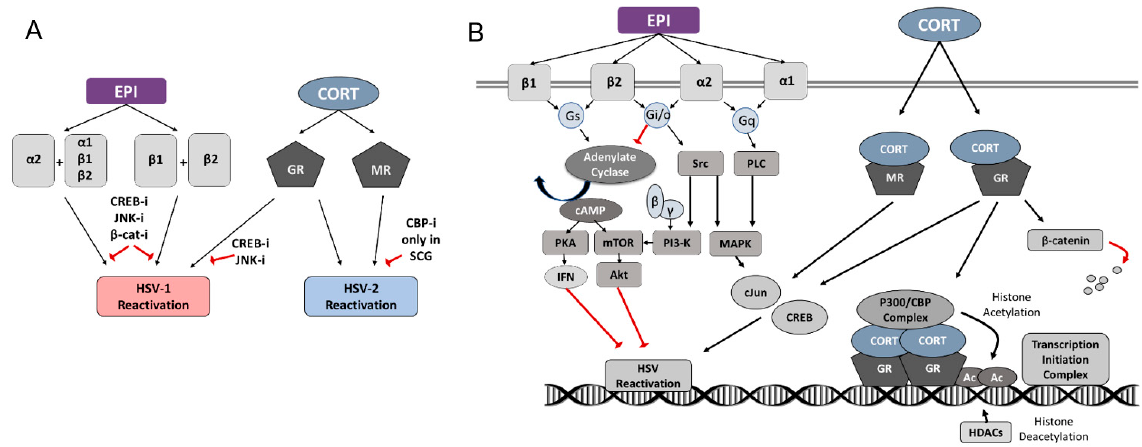
Figure 7. Adrenergic and glucocorticoid signaling pathways and HSV reactivation pathways. ( A ) Epinephrine (EPI) induces HSV-1 reactivation through the activation of α 2 and any other AR, or through the activation of β 1 and β 2, which can be blocked by the inhibitors of CREB, JNK, or β -catenin. Corticosterone (CORT) induces HSV-1 reactivation through the glucocorticoid receptor (GR), which can be blocked by the inhibitors of CREB or JNK. CORT induces HSV-2 reactivation through either glucocorticoid (GR) or mineralocorticoid (MR) receptors; the only factor we identified able to block HSV-2 reactivation was a CBP inhibitor, and only in SCG neurons. ( B ) Epinephrine (EPI) activates multiple adrenergic receptors on peripheral neurons ( α 1, α 2, β 1, β 2), which couple with different G-protein α subunits (Gq, Gi/o, Gs), which can activate different signaling cascades. Corticosterone (CORT) activates signaling cascades through cytosolic glucocorticoid (GR) and mineralocorticoid (MR) receptors. Cytosolic effector proteins and transcription factors mediated by EPI and CORT signaling include adenylate cyclase, cyclic AMP (cAMP), protein kinase A (PKA), interferons (IFN), the mechanistic target of rapamycin (mTOR), protein kinase B (Akt), protein kinase Src, phosphoinositide 3-kinase (PI3-K), phospholipase C (PLC), mitogen-activated protein kinases (MAPKs), c-Jun, cAMP response element-binding protein (CREB), CREB binding protein (CBP), p300/CBP Complex, histone deacetylases (HDACs), and β -catenin. Black arrows indicate stimulation or activation; red arrows indicate inhibition.